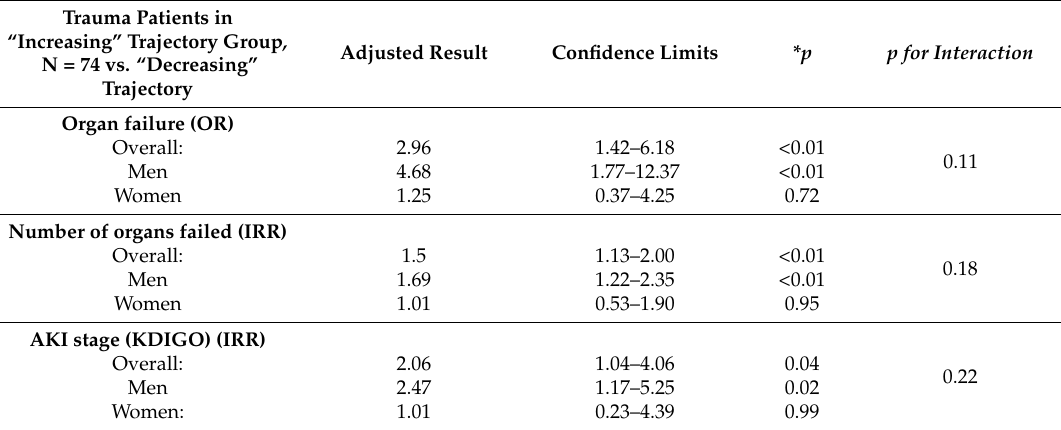
Table 3. Multivariable regression analysis for the association between NLR in “increasing’ trajectory and outcomes compared to those in “decreasing” trajectory among trauma patients admitted to the intensive care